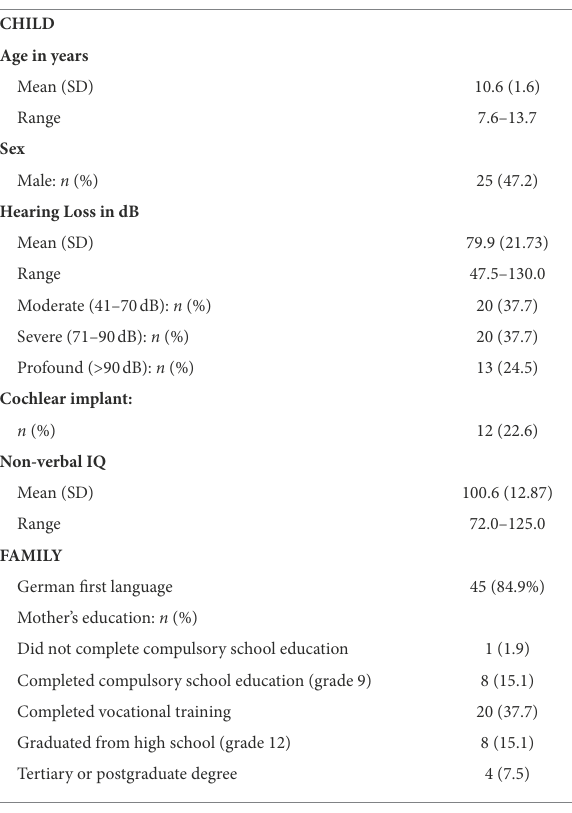
TABLE 2 Sample characteristics ( n = 53).